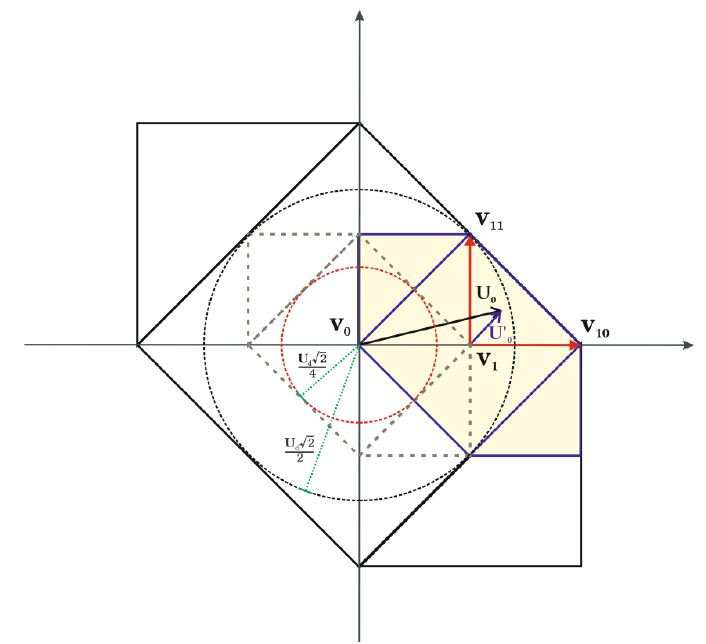
Figure 5. Transposition of U 0 coordinates to one of outer two-level hexagons, which gives the U’ 0 . After the transposition, V 1 vector is the local 0 vector. U’ 0 is synthesized by a combination of V 1 , V 10 , and V 11 as in a two-level inverter. The outer circle represents the maximum modulation depth without overmodulation, and the inner circle represents half of the modulation depth.